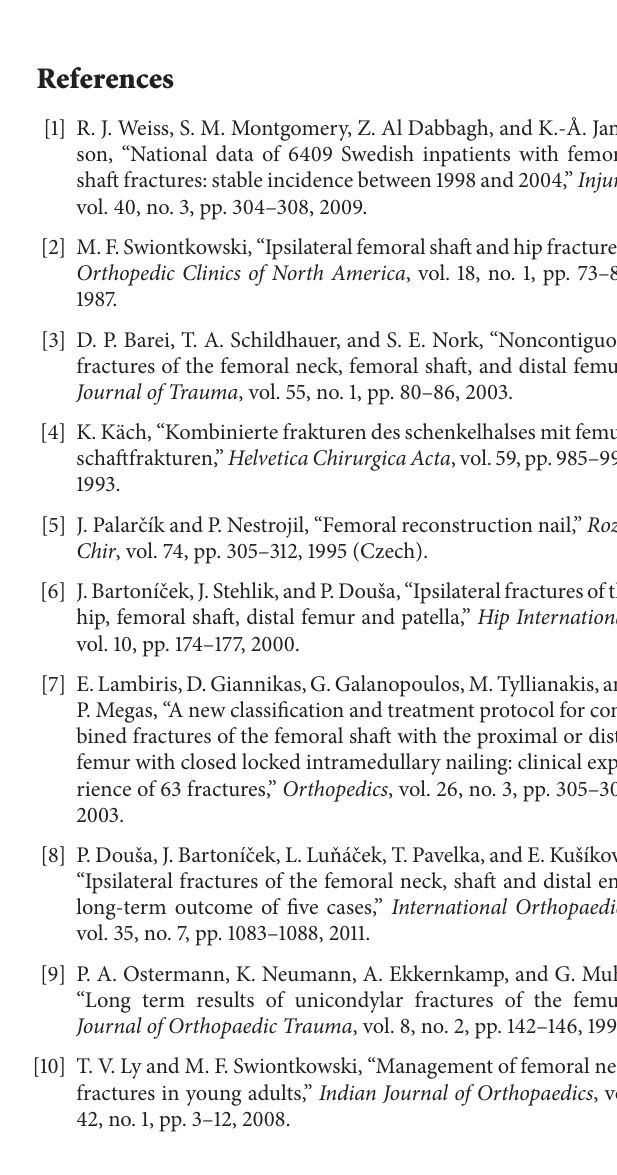
Figure 2: Case Report 2: (a)-(b) preoperative images, (b)–(d) postoperative images. The proximal fracture was reduced and stabilised with a three-hole plate and dynamic hip screw (DHS) with a derotation screw and a lateral approach was used to stabilise the distal femur fracture with a 14-hole locking